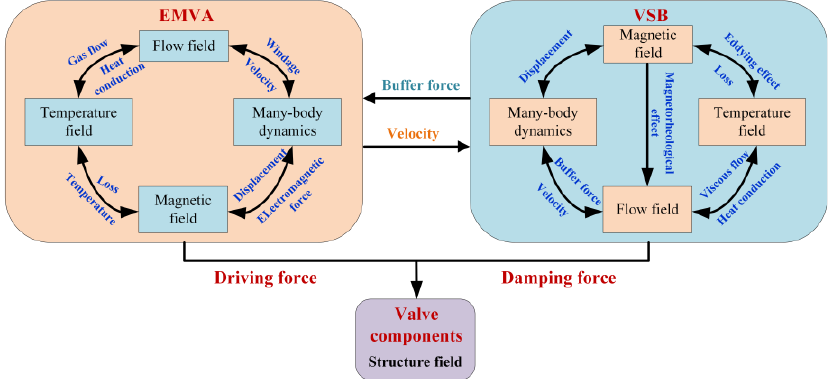
Figure 14. Coupling relationship of EMVV system.